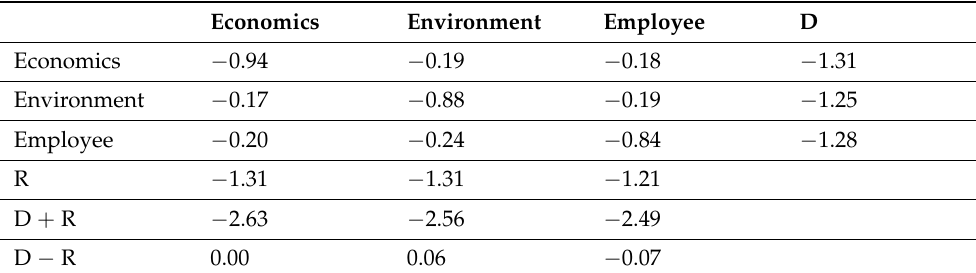
Table 2. The direct/indirect main aspect matrix.